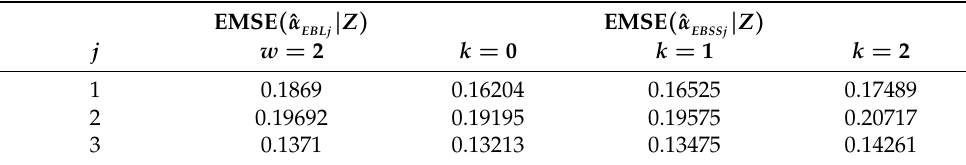
Table 8. Results of calculated EMSE for ˆ α using s = 10, β = 3.0, u = 3, v = 4.